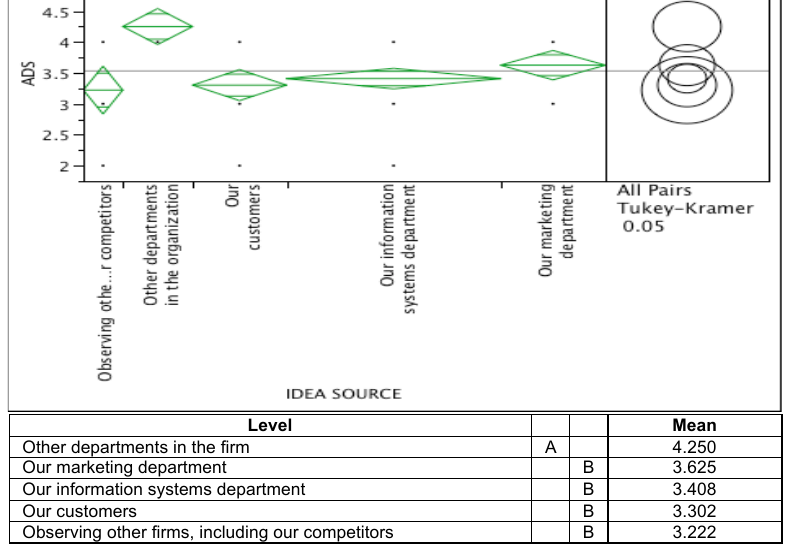
Effects of idea source on perceptions of app effectiveness